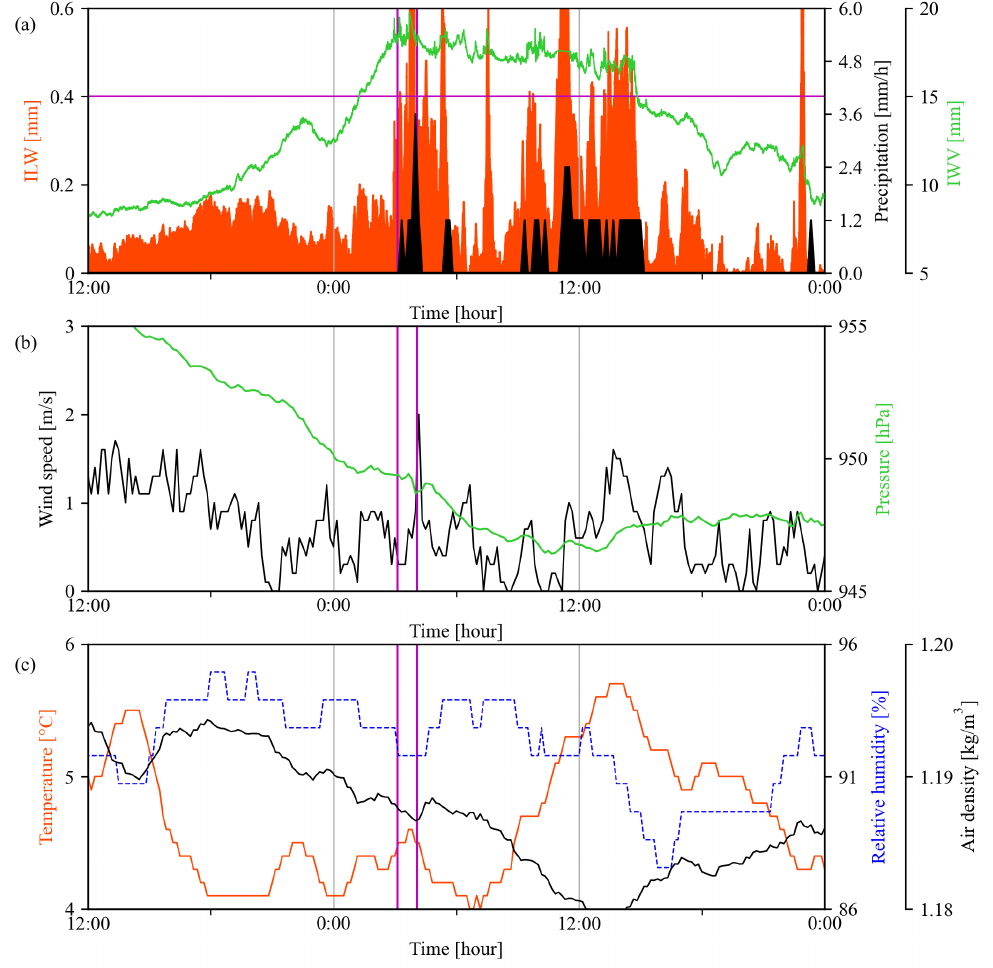
Figure 6. Time series of TROWARA and meteorological data from 1 January at 12:00 UT to 2 January at 24:00 UT, 2016. ( a ) Time series of IWV (green solid line) and ILW (red area) provided by TROWARA, and the precipitation (black area) observed by the rain gauge at the ExWi weather station. The two purple vertical lines represent the onset of light rain and moderate rain, respectively. The purple horizontal line is ILW = 0.4 mm. ( b ) Time series of surface pressure (green solid line) and wind speed (black solid line) observed by the ExWi weather station. ( c ) Time series of surface temperature (red solid line) and relative humidity (blue dashed line) observed by the ExWi weather station, as well as air density (black solid